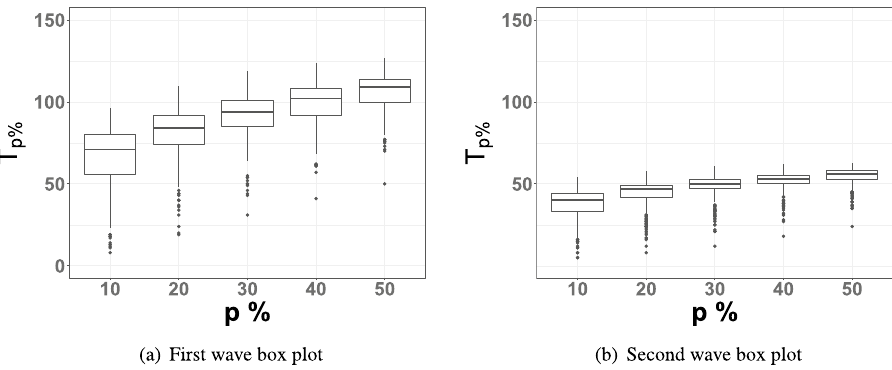
Figure 2. Box plot in ( a ) portrays T p % across 394 Indian districts during the first wave (starting in 05/01/2020). The box plot in ( b ) portrays the same for the second wave (starting in